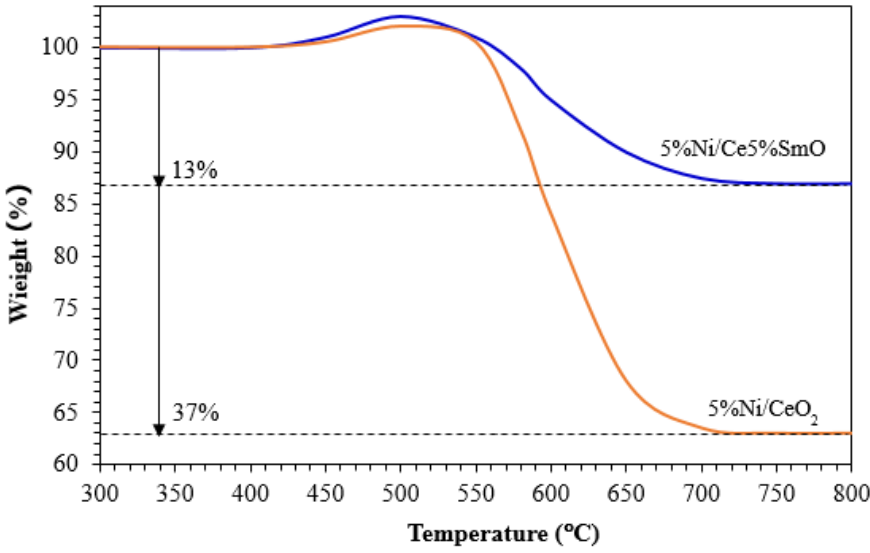
Figure 8. Thermogravimetric analysis of the used Ni catalysts prepared by combustion